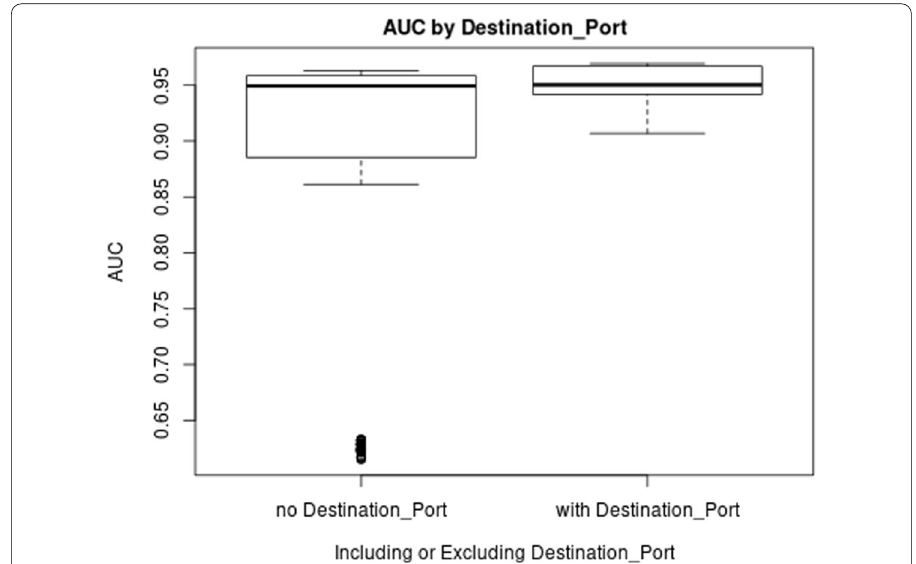
Fig. 10 Box plots of AUC grouped by whether the dataset contains the Destination Port feature; Tukey’s HSD test indicates including Destination Port produces significantly different results